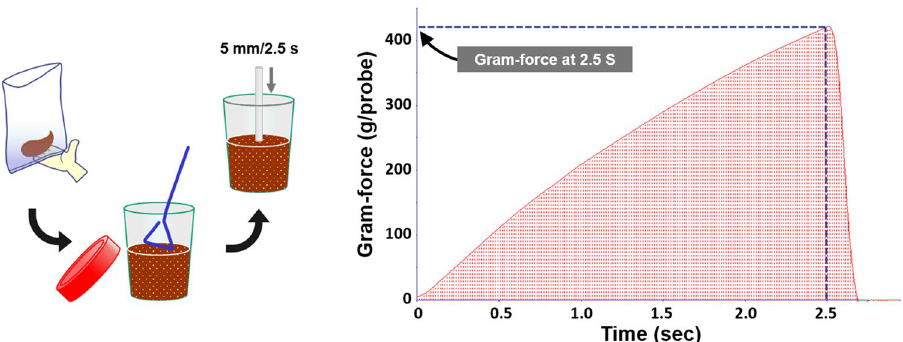
Figure 3. Schematic view of stool consistency measurement by texture analyzer. Whole stool was homogenized by hand in a plastic bag. A portion was placed in a plastic container and flattened with a plastic spreader. A cylindrical stainless steel probe (ø 6 mm) moved downward at a constant 2.0 mm/s, and the gram-force against the probe was monitored until the probe reached 5 mm down from the surface. The gram-force at the inflection point was measured as an outcome of stool